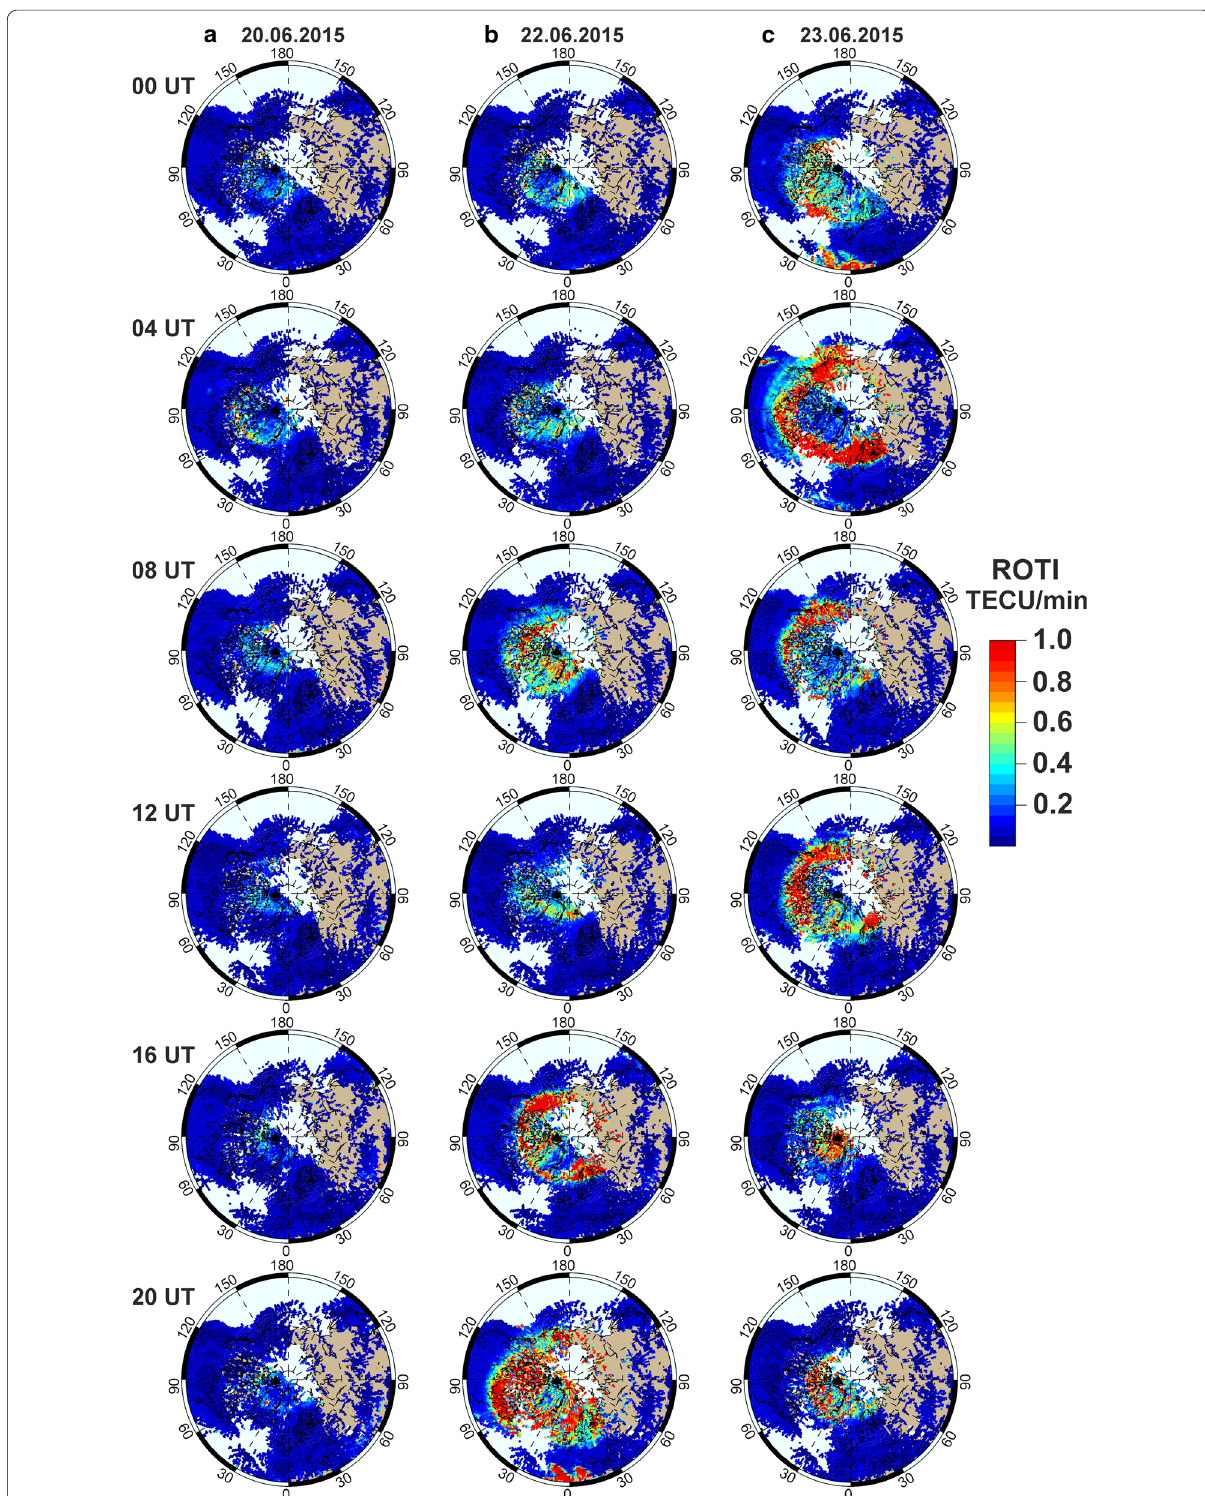
Fig. 4 Two-dimensional ROTI maps derived from the combined GPS and GLONASS observations over the northern hemisphere for a quiet day of a June 20 and disturbed days of, b June 22 and c June 23, 2015. Each vertical row shows the ROTI maps constructed with 1 h resolution and shown here with 4-h interval. Black dot depicts location of the geomagnetic